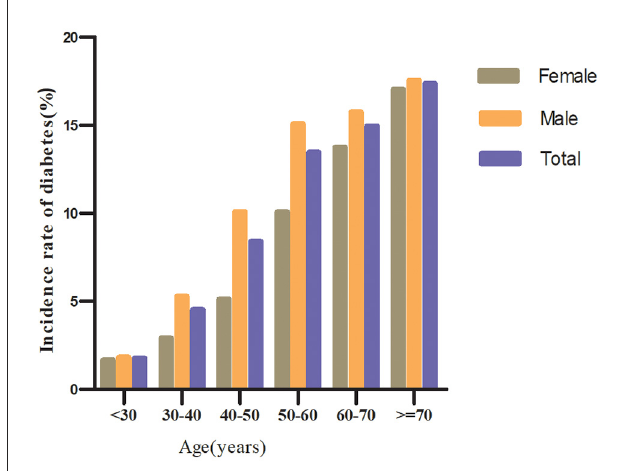
FIGURE4 The incidence of diabetes in prediabetic patients of age stratification by 10 intervals. It shows that the incidence of diabetes in participants with prediabetes was higher in men than in women, regardless of age group. It was also found that the incidence of diabetes increased with age in both men and